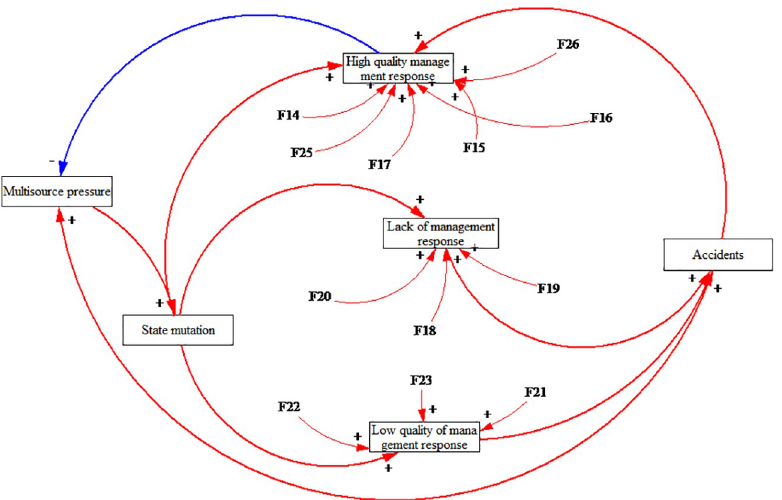
Fig 6. The response mechanism of HATC